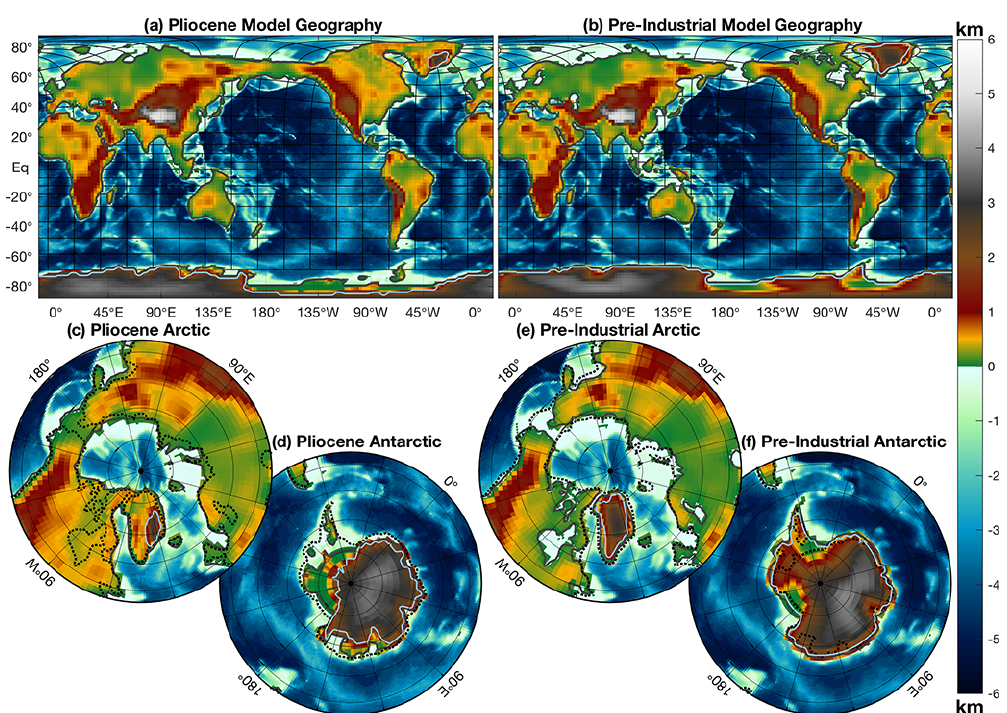
Figure 1. Model geography as applied in our different (a) Pliocene and (b) pre-industrial cases. Both the bathymetry and topography are shown at the native model grid, with the CAM4 rectangular grid superimposed on the finer POP2 curvilinear grid wherever the land fraction is at least 0.5 (also indicated by the thick grey contour line). The light blue contour line shows the extent of land ice, as imposed by the land use distribution. (c, e) Northern and (d, f) southern polar stereographic views of Pliocene and pre-industrial model